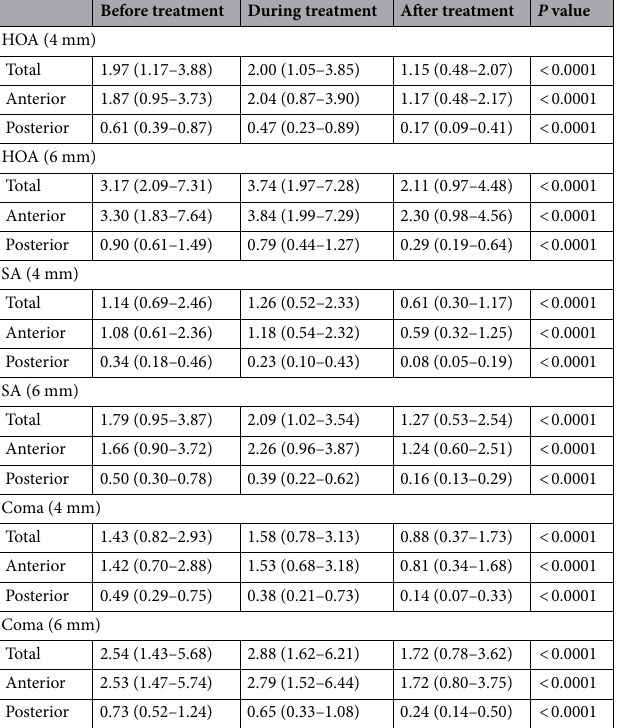
Table 2. Longitudinal changes in corneal higher-order aberrations during treatment. The values are presented as median (interquartile range) (μm). P values were compared between values before and after treatment using the Wilcoxon signed-rank test. Coma coma aberration, SA spherical aberration, HOA higher-order aberration.